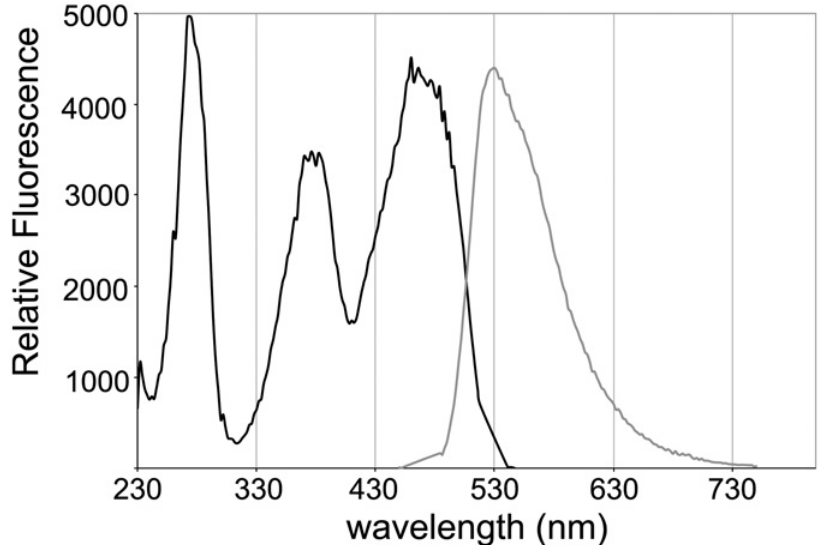
Fig 2. Excitation/emission of LucY. Excitation scan (black) performed with emission at 528nm and emission scan (gray) was performed with excitation at 465nm. doi:10.1371/journal.pone.0124272.g002 fluorophore; the values are expressed relative to the brightness of LucY (Table 1). LucY en- hances FAD brightness by approximately 10-fold, and it is the brightest of the MurB homologs